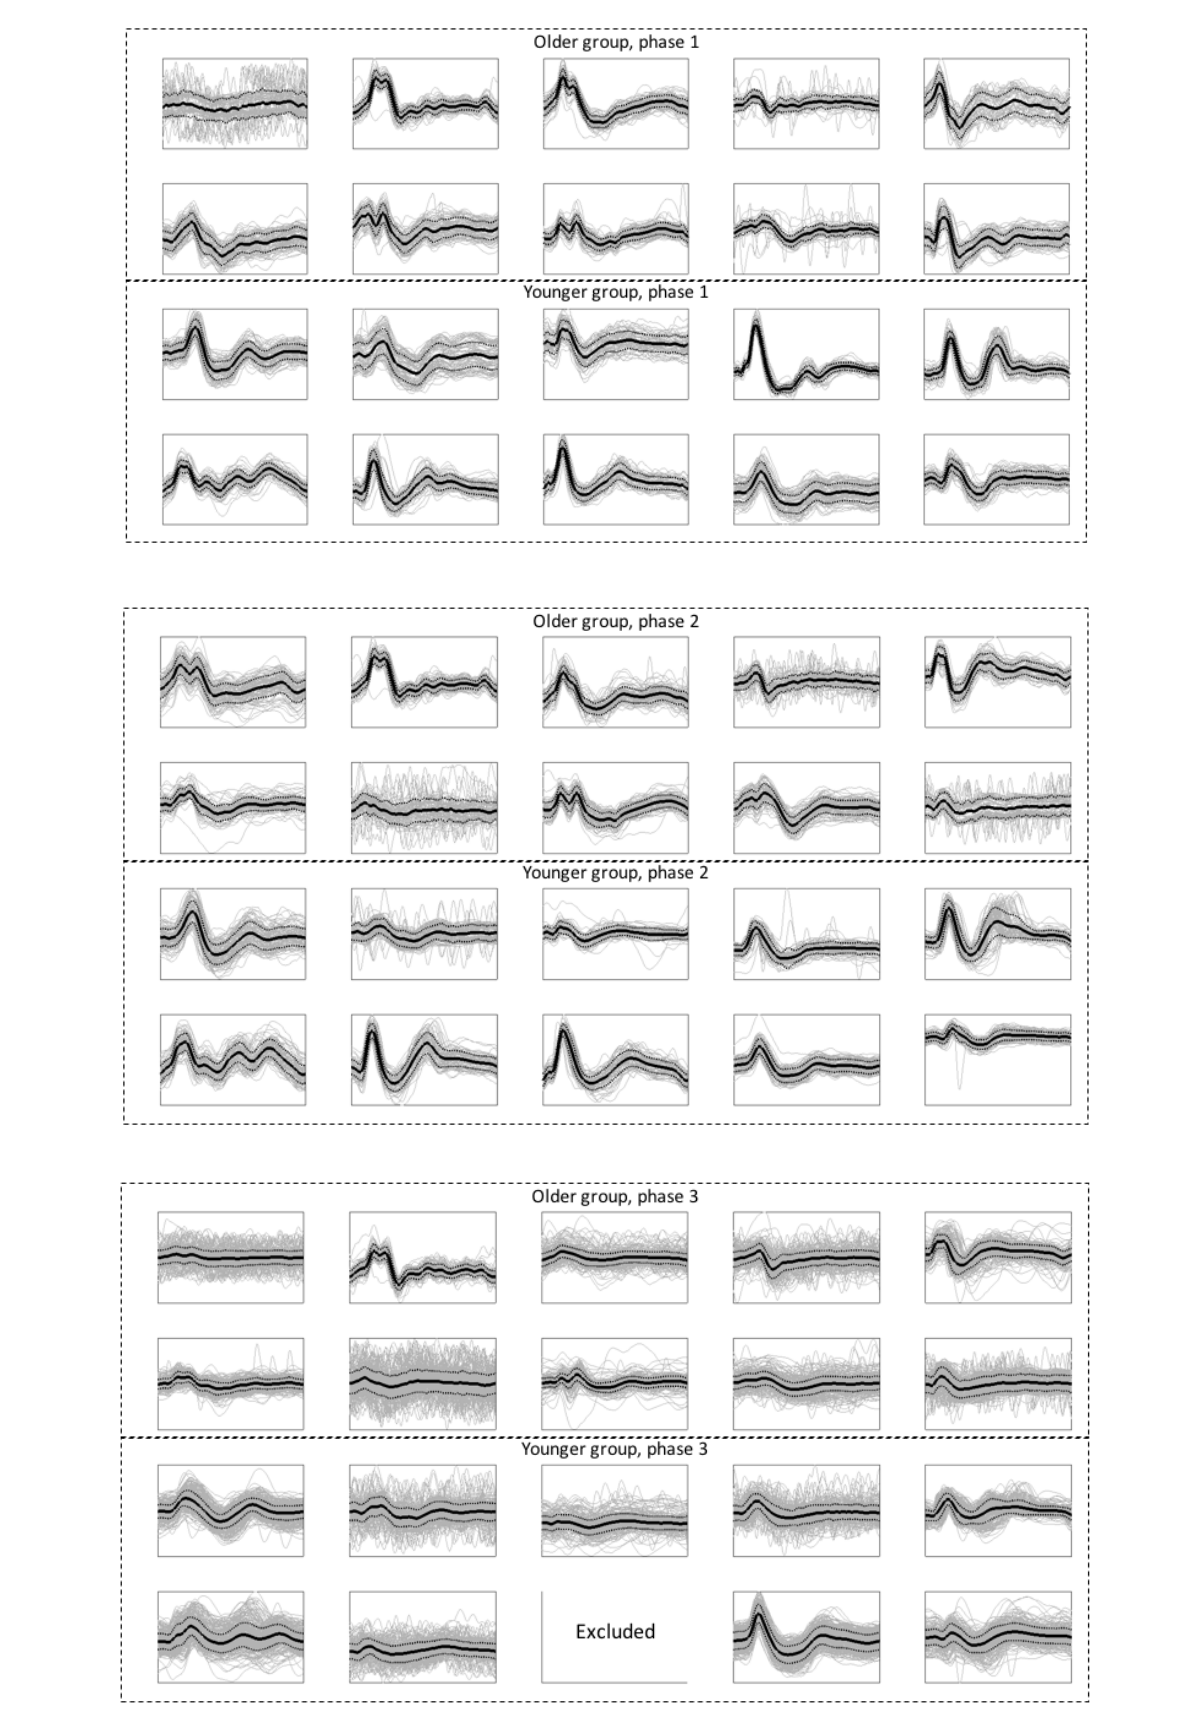
Fig. 2. ICG (-dZ/dt) waveforms for each beat, resampled to an even length of one second (gray lines). The ensemble averages for every individual and phase is shown in the thick black line with ±1 standard deviation in the dashed